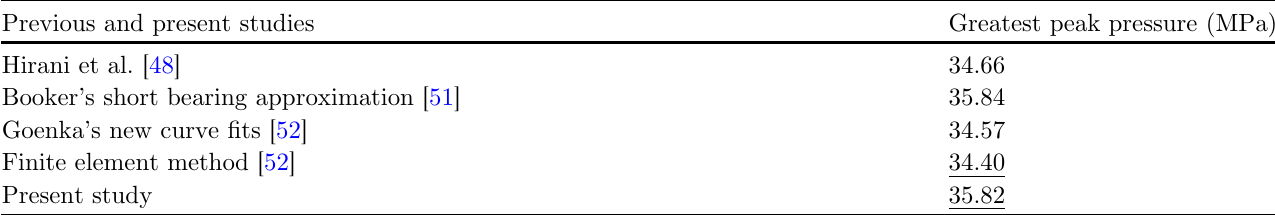
Table 4. Results for the Ruston Hornsby Diesel engine big-end